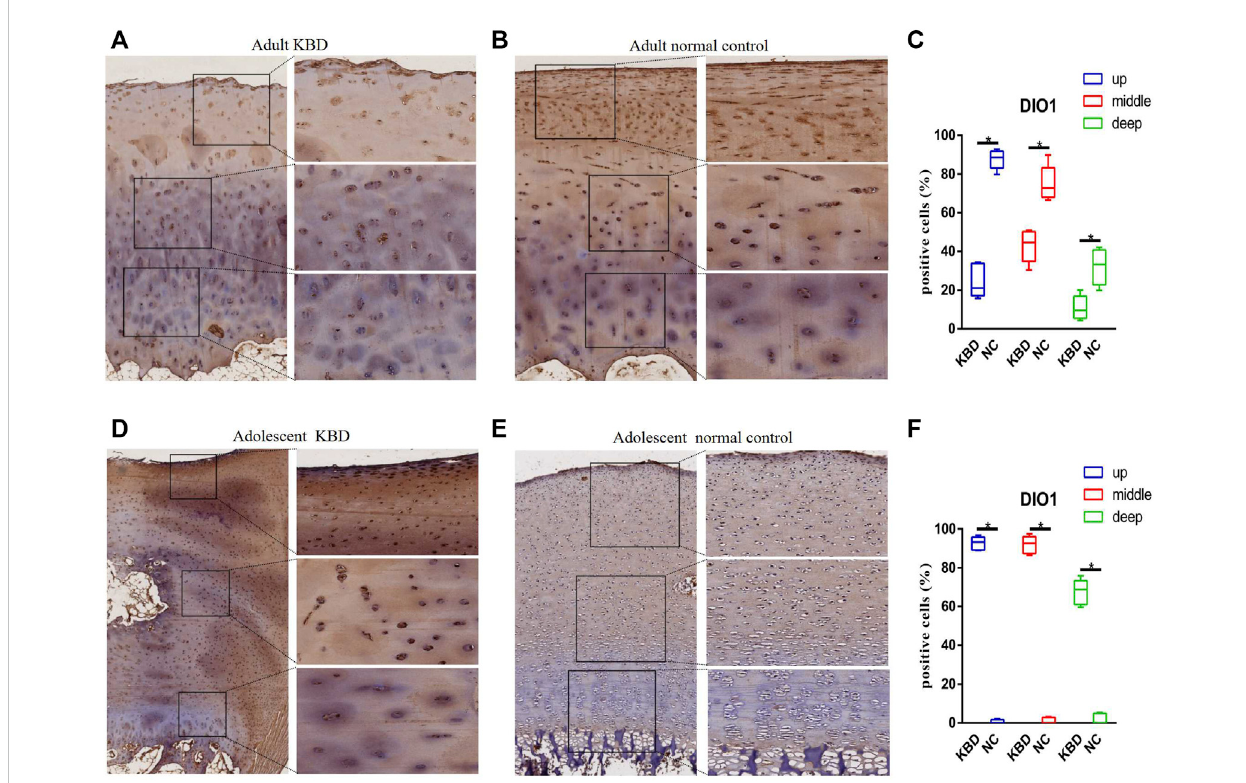
FIGURE 4 Representative immunohistochemistry staining of DIO1 in adult KBD (A) , adult normal control (B) , adolescent KBD (D) , and adolescent normal control (E) cartilagetissues(scalebar:left,500 μ m;right,100 μ m)andcomparativequanti fi cationofpositivecellsofdifferentareas(up,middle,anddeep) in adult (C) and adolescent (F) cartilage tissues displayed by a box plot ( n = 3). * p <